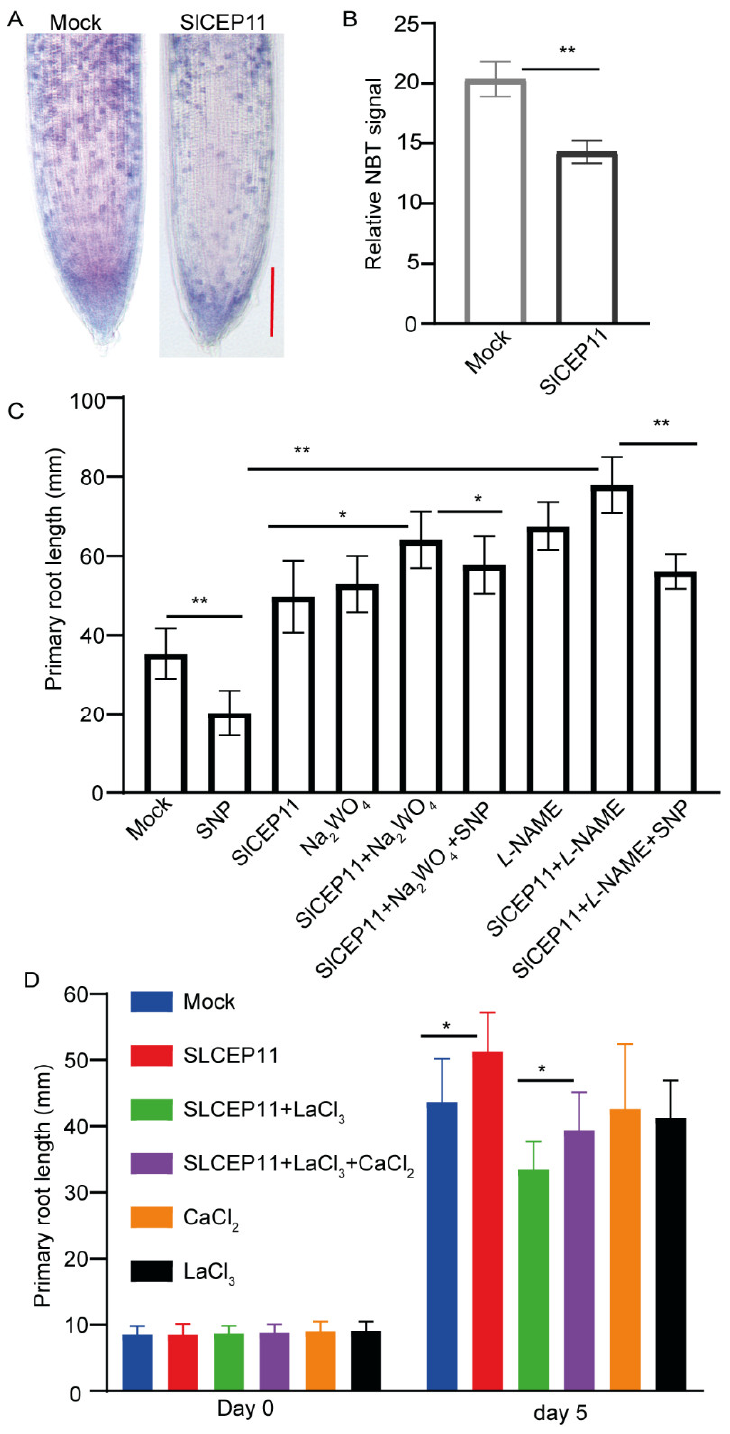
Figure 5. NO and Ca 2+ are required for SlCEP11-mediated tomato root growth. ( A ) Representative images showing the NBT staining in synthetic SlCEP11 peptide treated tomato primary root for 6 days. ( B ) Quantification of NBT signal intensity. ( C ) Quantification of tomato primary root length upon NO inhibitors treatment in presence of synthetic SlCEP11 peptide for 6 days. ( D ) Quantification of tomato primary root length upon Ca 2+ inhibitor treatment in presence of synthetic SlCEP11 peptide for 6 days. n = 10–15 seedlings, data represent mean ± SD, * p < 0.05 and ** p < 0.01 were determined by one-way ANOVA. Scale bar = 200 µ